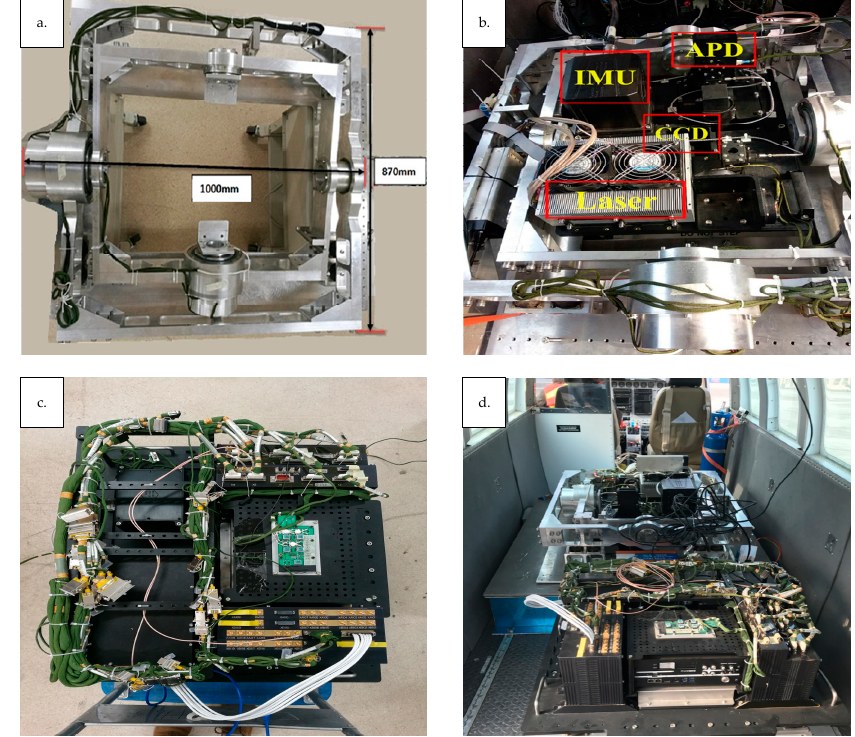
Figure 1. ( a ) Two-dimensional stabilized platform; ( b ) laser, CCD, IMU, and APD are installed in ( a ); ( c ) signal processing and control unit; ( a , c ) are mounted on the airplane adjacent to one another ( d ).